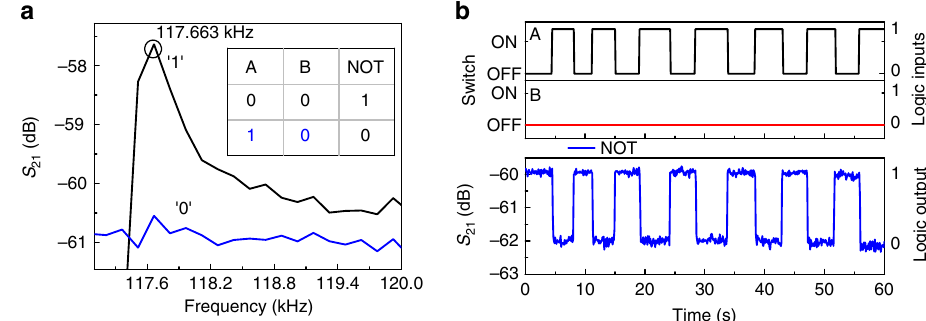
Figure 5 | Demonstration of NOT gate. ( a ) Frequency responses of the resonator for different logic input conditions, where (0,0) logic input condition shown in black has high S 21 transmission signal at 117.663kHz and others have low S 21 transmission signal represented by 1 and 0, respectively. Truth table of NOT logic gate is shown in the inset. ( b ) Demonstration of NOT logic operation when the frequency of the a.c. input signal is chosen as 117.663kHz. Two input signals, A and B are shown in black and red, respectively, where the switch OFF/ON corresponds to 0/1 logic input conditions. S 21 transmission signal in blue corresponds to the logic output and fulfills the NOT truth table. frequency of 117.663 kHz. The NOR gate truth table is shown in condition only. The resonator is tuned away from its series the inset of Fig. 4a. The time response of the resonator showing resonance frequency of 117.663 kHz by other logic input condi- binary inputs A and B and the corresponding logic output is tions, (0,1), (1,0) and (1,1), respectively. Hence, shows low S 21 transmission signal denoted as logic output 0 (in black) at the depicted in Fig. 4b. It clearly shows NOR logic operation as the NATURE COMMUNICATIONS|7:11137|DOI: